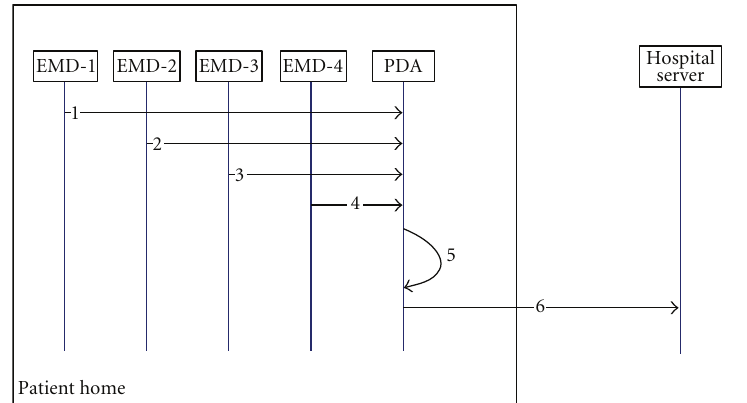
Figure 5: A sequence diagram of flow of medical data measurements from patient’s home toward the data server which is located at the patient’s hospital.